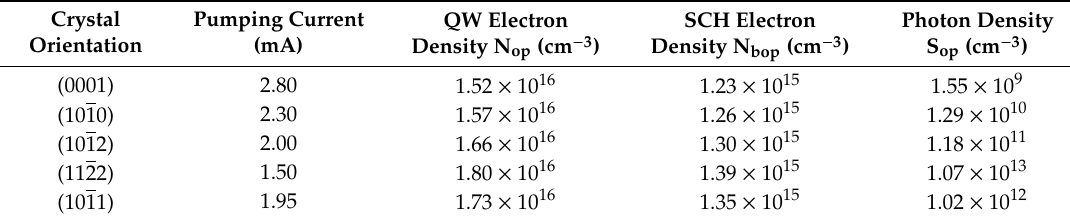
Table 6. Crystal orientation-dependent operating points close to threshold.